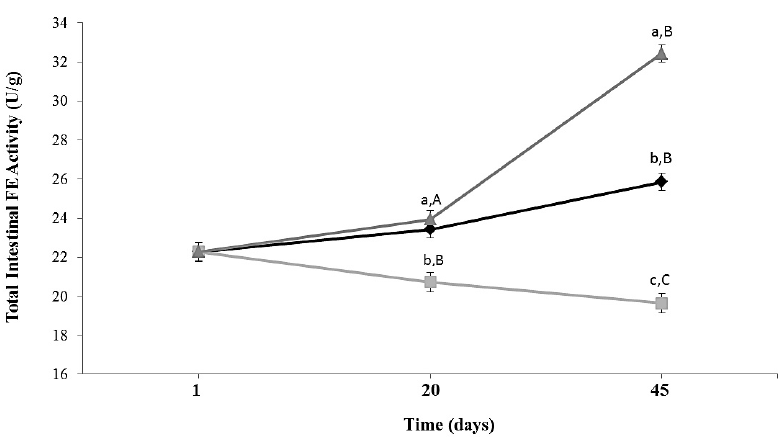
Figure 2. Total intestinal feruloyl esterase activity in ad libitum fed and caloric restricted mice: ( (cid:7) ) ALF: ad libitum fed Group; ( (cid:4) ) CR: caloric restriction Group; and ( (cid:78) ) CR-Lf: caloric restriction plus L. fermentum CRL1446 administered Group. Data are means ˘ SEM ( n = 6 per group at each time point). Data with different lowercase letters (a–c) at the same period of treatment and data with different uppercase letters (A–C) at same group are significantly different ( p < 0.05) according to ANOVA statistical